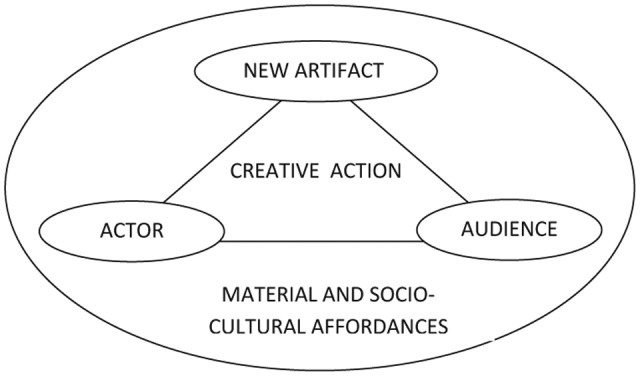
Five A’s framework of creativity (Glăvenau, 2013, p. 72).